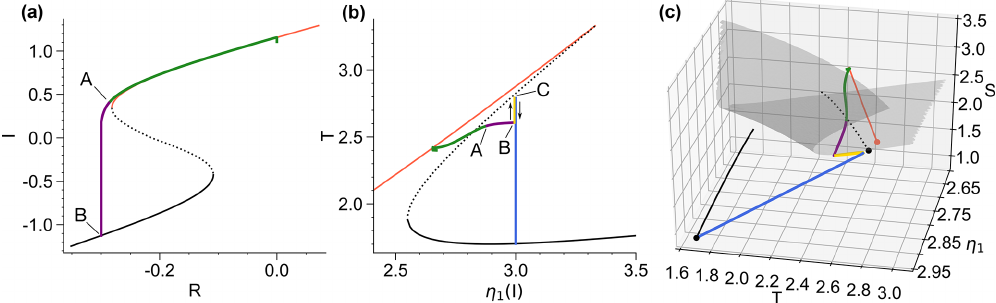
Figure 10. Cascading stadial–interstadial transition in the coupled sea ice–ocean model where R is ramped from R = 0 to R = − 0 . 3 within 340 years and kept constant afterwards. (a) Trajectory of the sea ice component as function of the control parameter R . (b, c) Trajectory of − κ(cid:50) ( I ( t )) · I ( t ). The tipping cascade consists of several steps the ocean component as function of the changing parameter η 1 ( I ( t )) = η 0 1 separated by the points A, B, and C and marked by different colors in the trajectories (see main text). The gray surface in (c) is the moving basin boundary corresponding to the changing η 1 ( I ( t )).